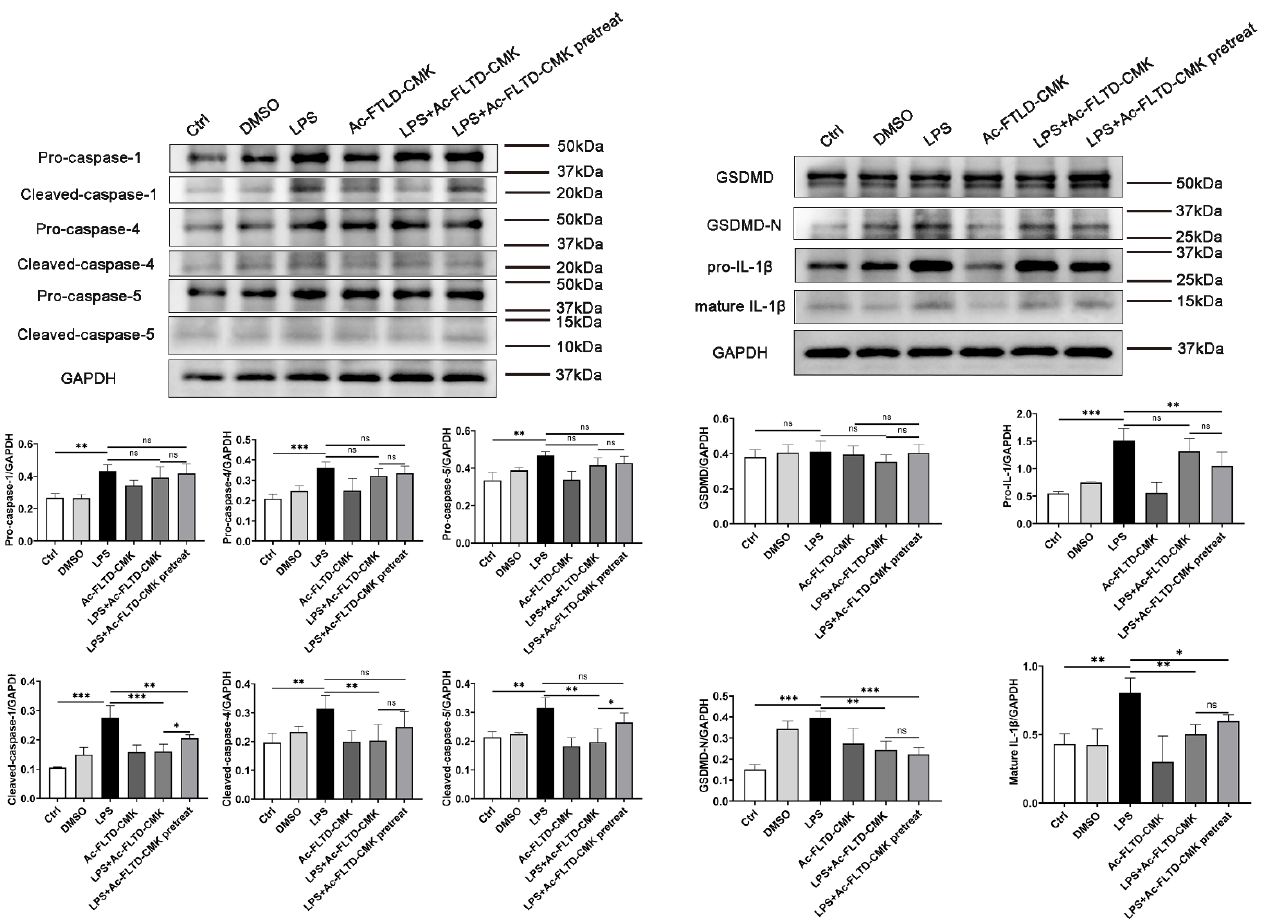
Figure 7. Caspase-1/-4/-5 were activated after LPS stimulation but inhibited by Ac-FLTD-CMK. THP-1-derived macrophages were stimulated with 1 μg/mL LPS for 6 h with or without Ac-FLTD-CMK. Pro-caspase-1, cleaved-caspase-1, pro-caspase-4, cleaved-caspase-4, pro-caspase-5, cleaved-caspase- 5, GSDMD, GSDMD-N, pro-IL-1 β and mature IL-1 β were examined by Western blot. Data are represented as the mean ± S.D. (one-way ANOVA, n = 3; *, p < 0.05; **, p < 0.01; ***, p < 0.001; ns, no